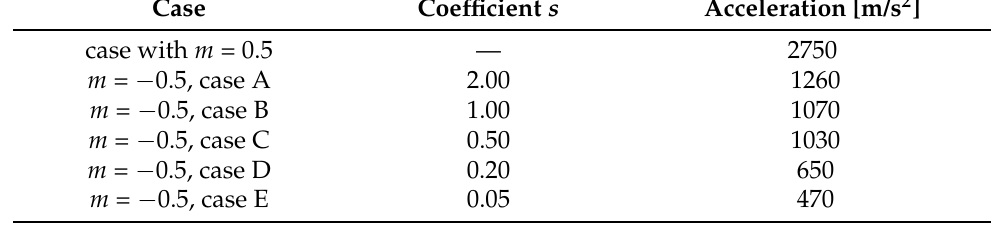
Table 1. List of material cases: Constant ( m = 0.5) and softening matter ( m = − 0.5).